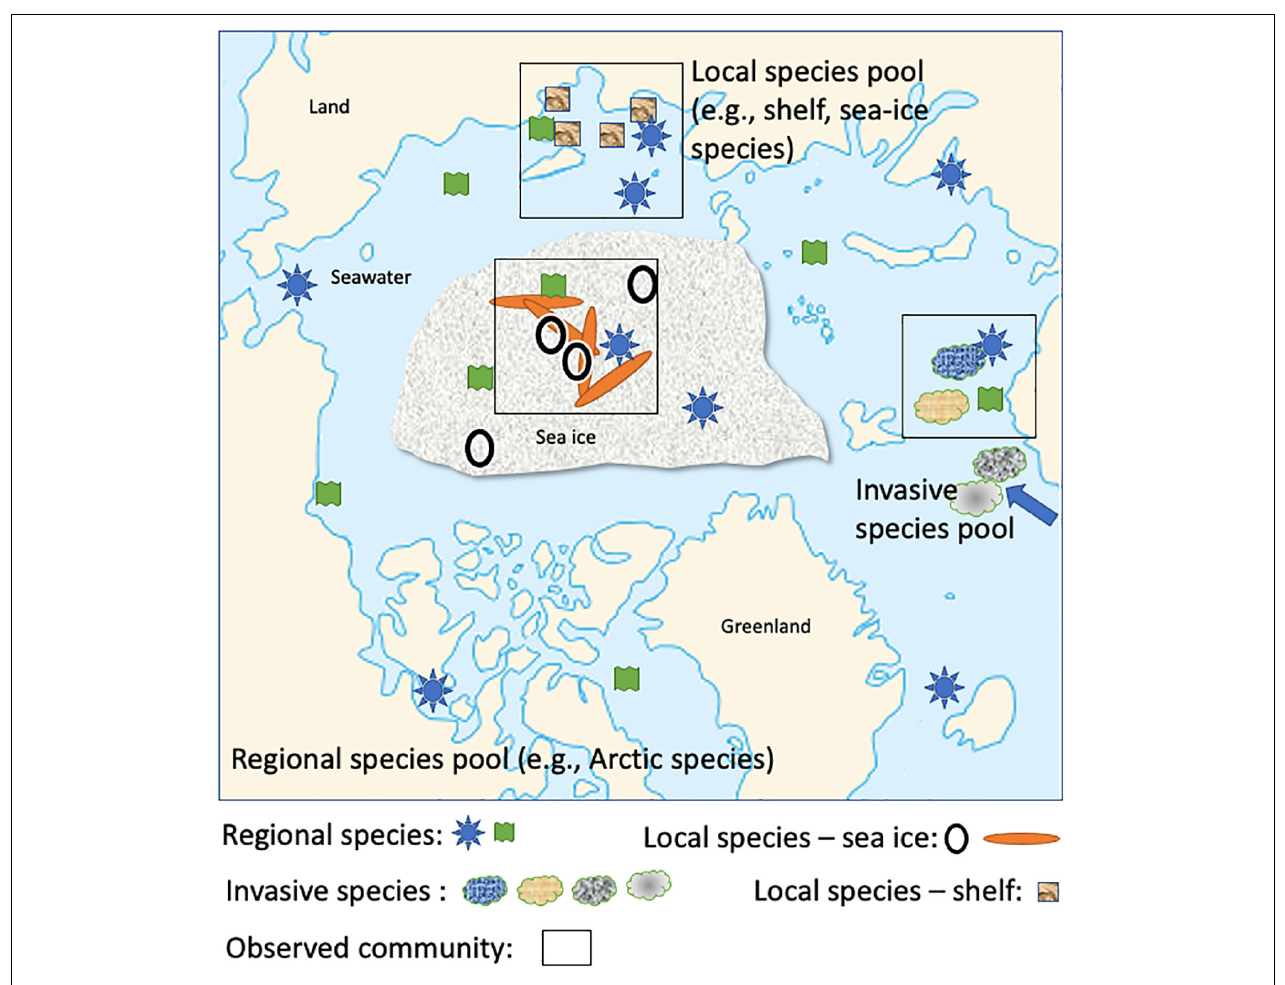
FIGURE 3 | Conceptual diagram of the assembly process influencing microbial communities at different spatiotemporal scales in the Arctic Ocean (e.g., regional, local). Geometric forms are arbitrary, but their composition represents how different microbial taxa (e.g., a specific geometric form such as a circle representing a taxon) contribute to complex microbiomes as the outcome of assembly processes at different spatiotemporal scales (Adapted from Ovaskainen et al., 2017). Drivers for the assembly process are likely a combination of abiotic and biotic conditions. For instance, the ephemeral nature of the sea-ice habitat in combination with strong gradients of temperature and salinity in brine channels can be assumed to significantly contribute to the assembly process of sea-ice microbiomes.